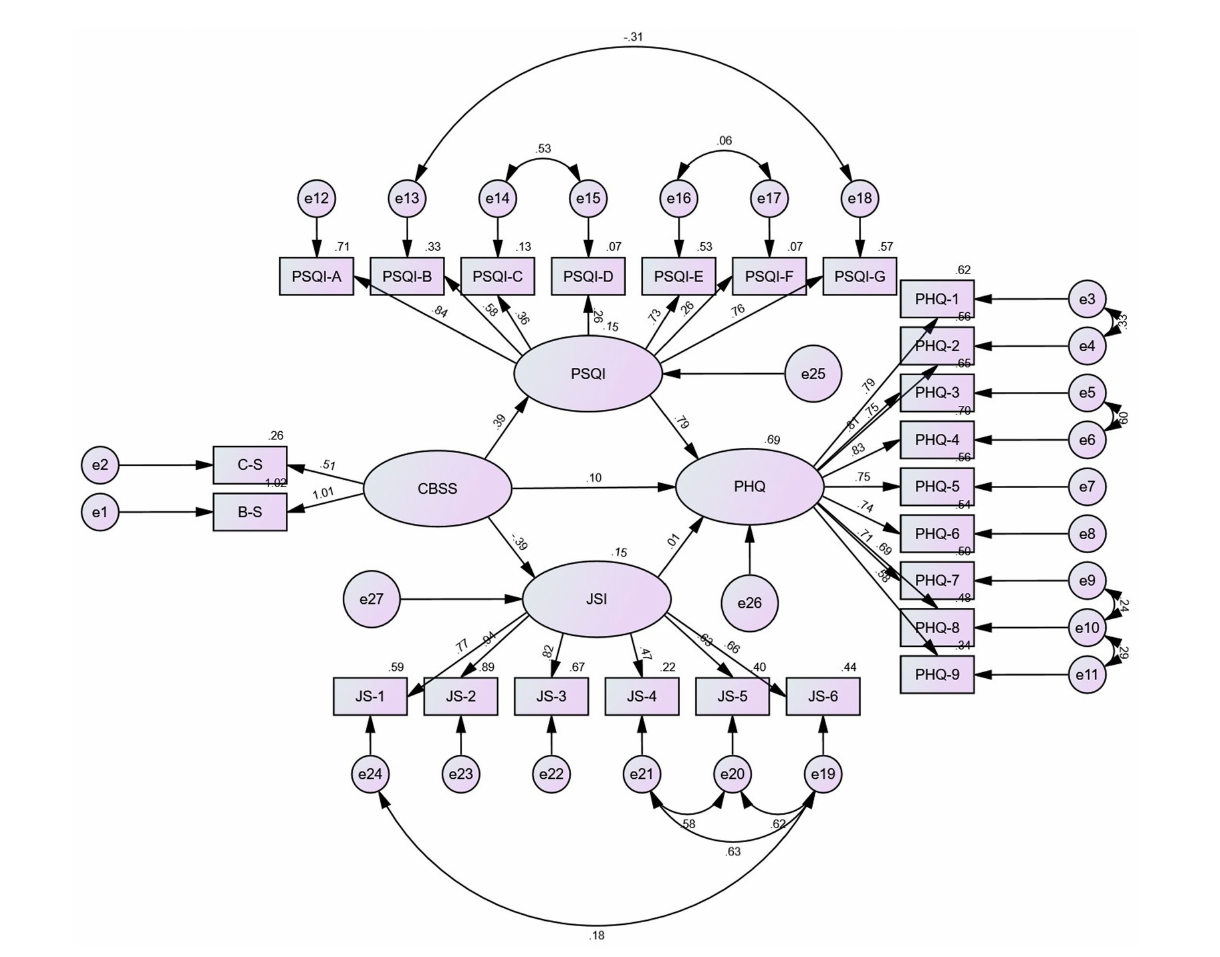
FIGURE 3 Results of the SEM analysis of the effects of sleep quality and job satisfaction mediate the association between work stress and depression among the sample of college degree or above. All the coefficients in the figure are standardized. The standardized coefficients of CBSS to JSI, CBSS to PSQI and PSQI to PHQ are significant at 0.001 level, CBSS to PHQ is significant at 0.05 level, and JSI to PHQ is not